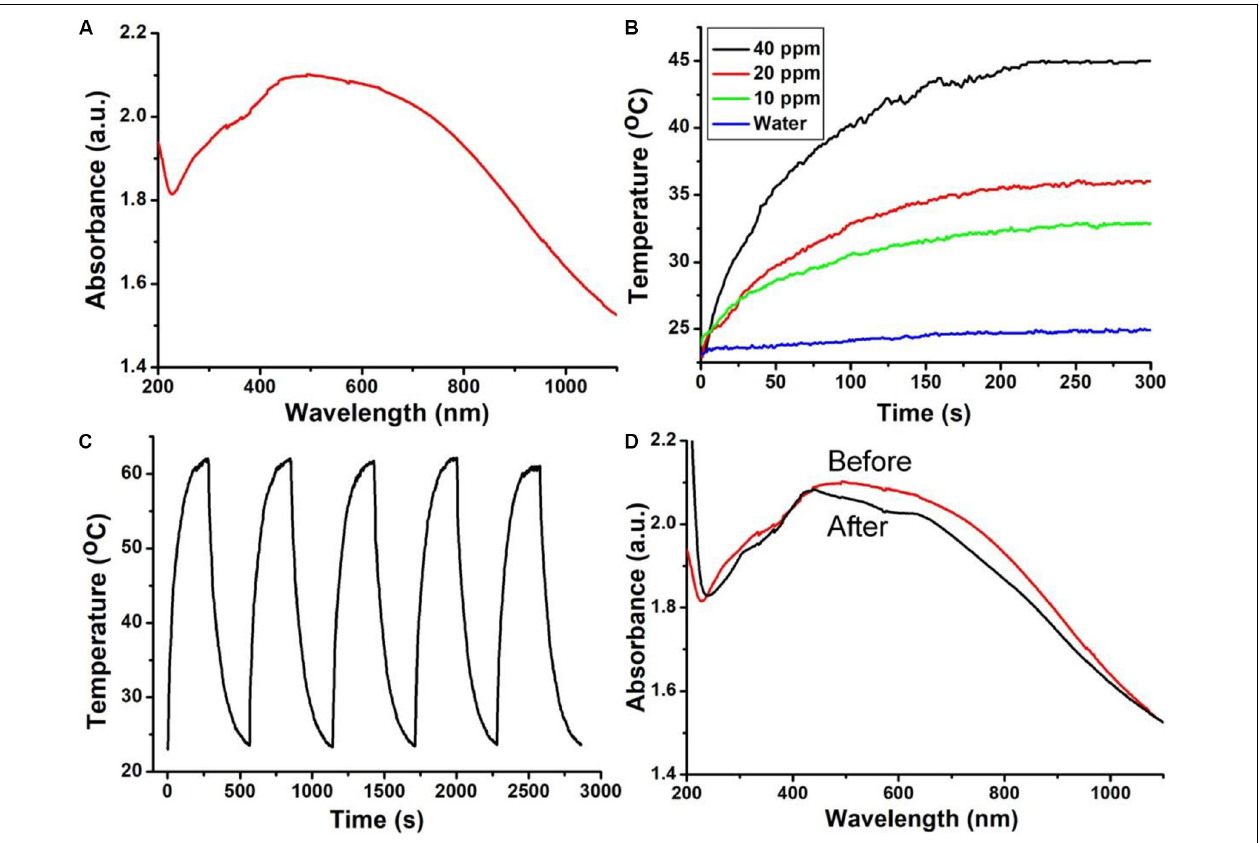
FIGURE 2 | (A) UV-vis spectra and (B) photothermal effect of Bi 2 S 3 nanorods. (C) Temperature change of Bi 2 S 3 nanorods during the five circles of laser ON/OFF. (D) UV-vis spectra of Bi 2 S 3 nanorods before (red line) and after photothermal stability